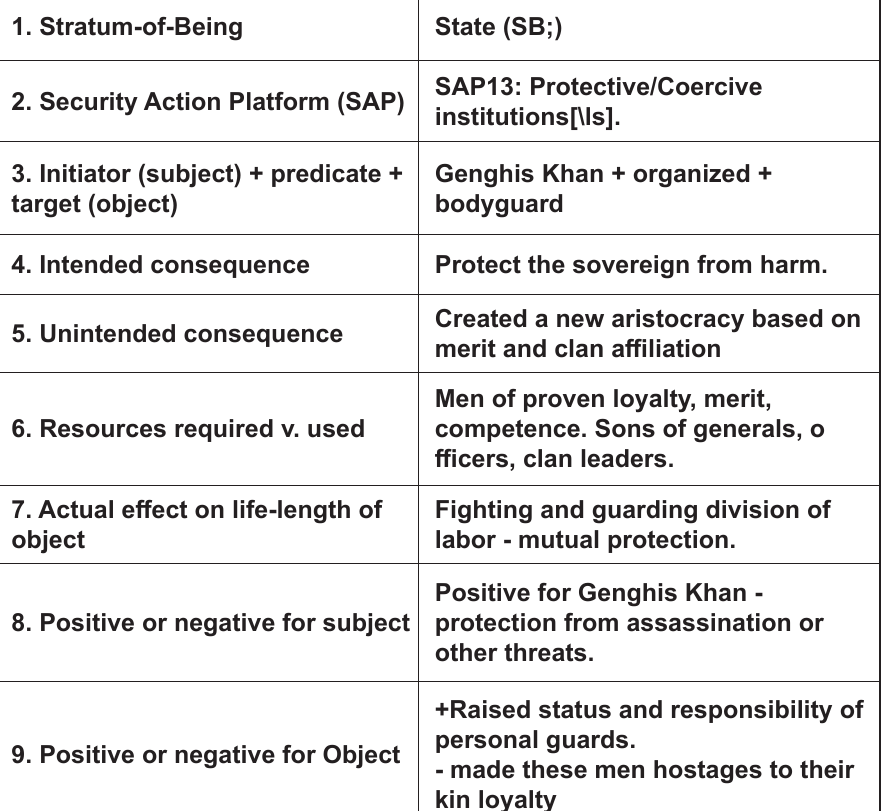
Figure 10:Genghis Khan organized bodyguard